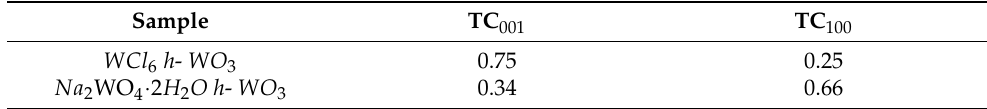
Table 1. Texture coefficients for the 001 and 100 facets of the Na 2 WO 4 · 2 H 2 O and WCl 6 synthesized h - WO 3 samples.